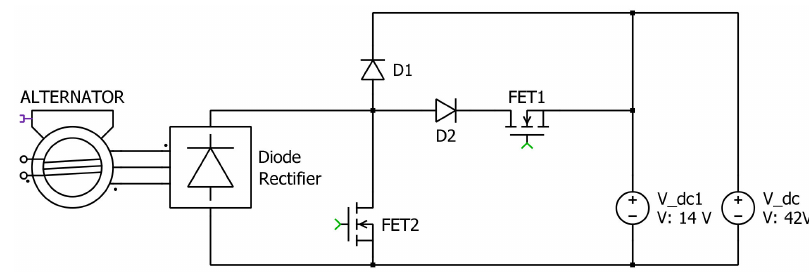
Figure 40. New dual output SMR circuit diagram “Reprinted from [48]”. The alternative circuit diagram is in Figure 41.